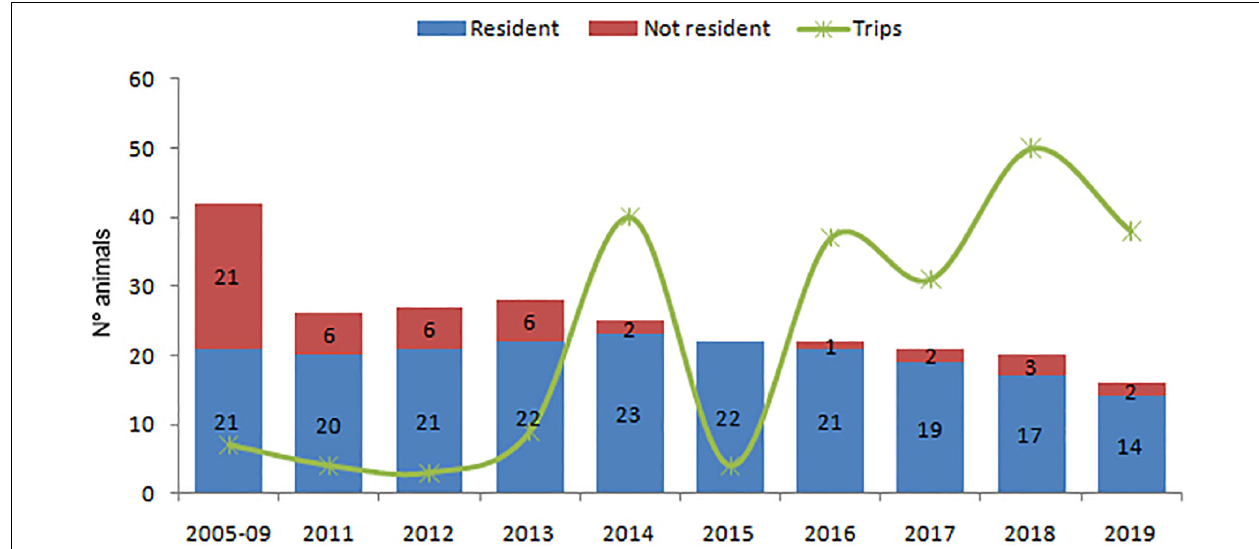
FIGURE 4 | Annual population estimates of the Posorja dolphin community. Resident dolphins in blue and non-residents dolphins in red. The green line indicates the number of trips per year conducted within the distribution area of the Posorja dolphin community. Periods 2005–2009 and 2011–2019. TABLE 3 | Annual population estimates with the Chapman estimator for closed populations and direct counts for each dolphin community. Year Posorja El Morro